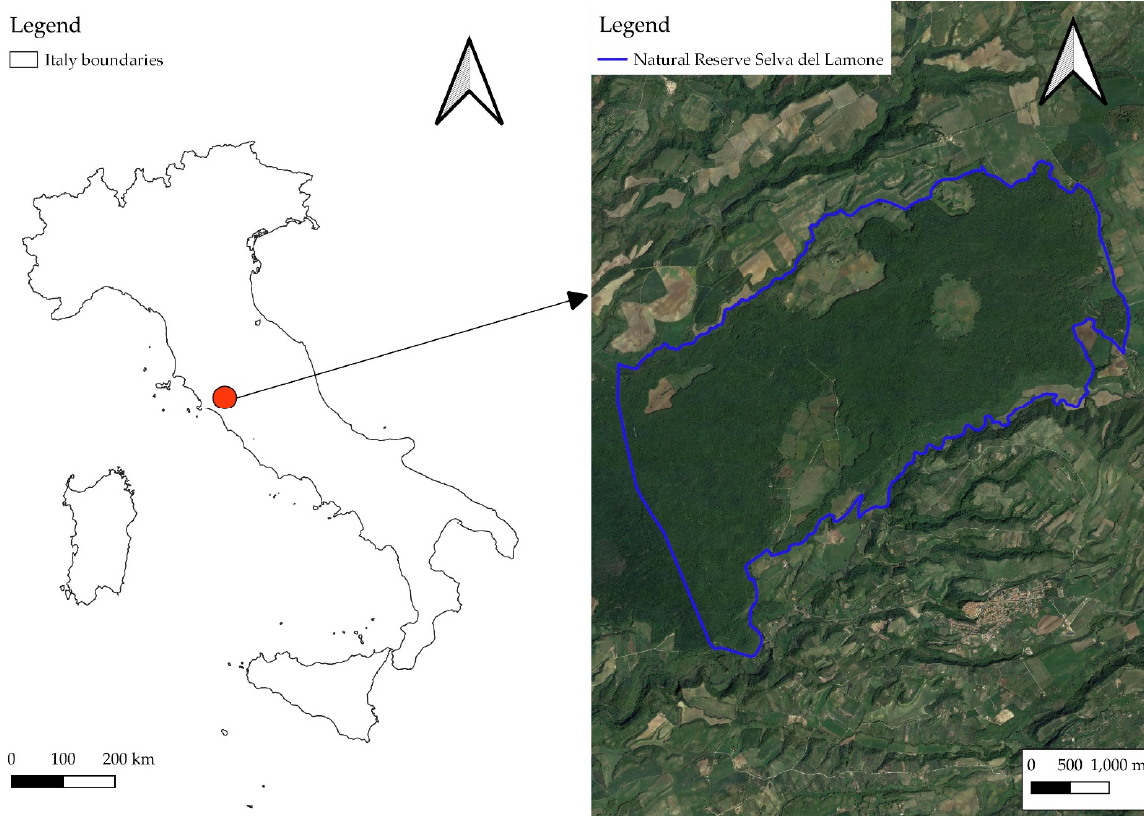
Figure 1. Aerial image of the study area and location within Italy.